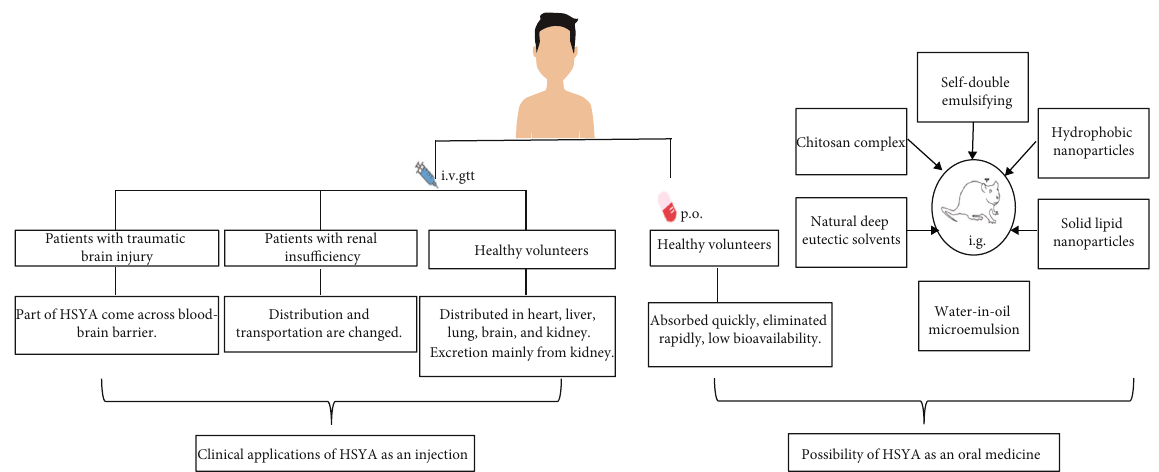
Figure 3: Clinical applications and possible medicine development of HSYA based on human and animal pharmacokinetic research. Abbreviation: HSYA: hydroxysa ffl or yellow